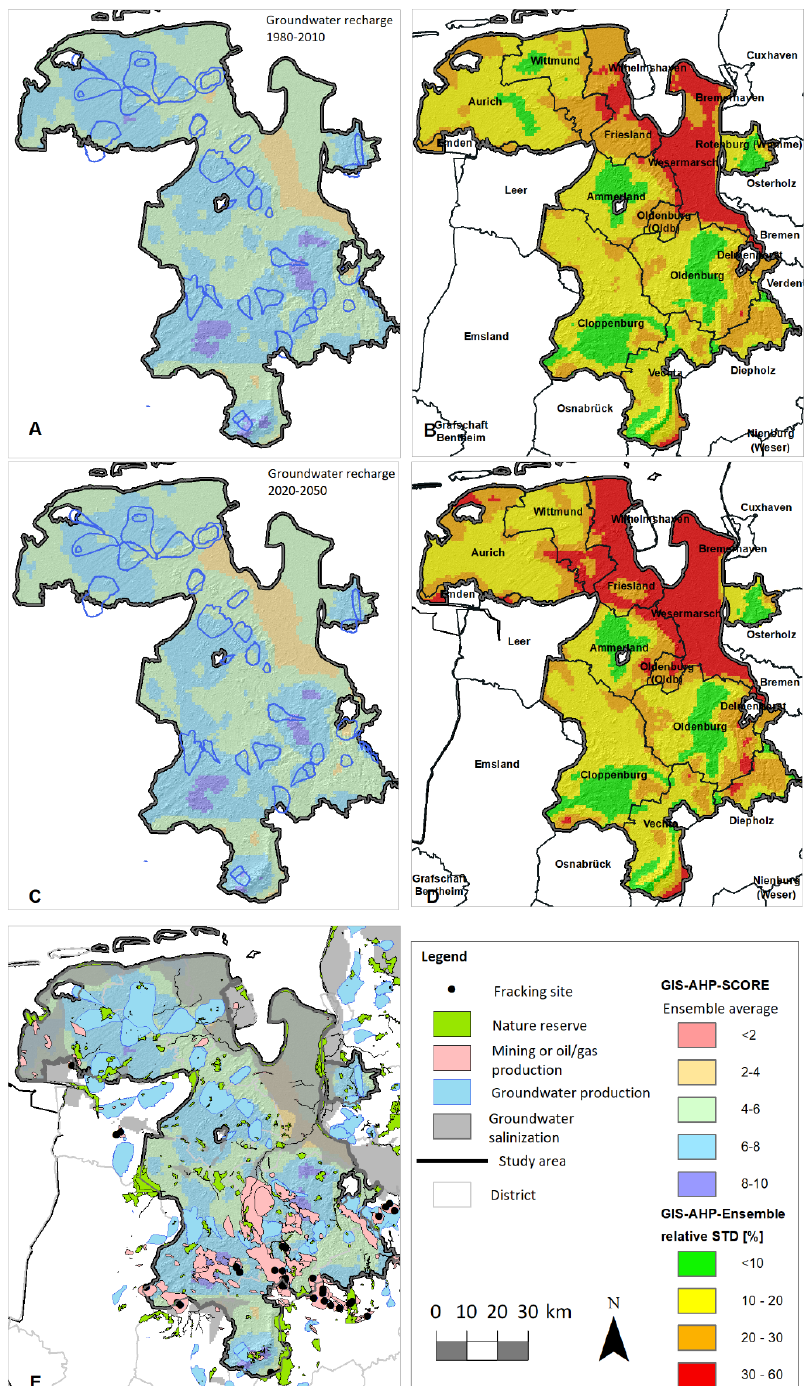
Figure 6. Results from the GIS-AHP ensemble: ( A ) average of GIS-AHP ratings from all five ensemble members together with long-established groundwater abstraction and protection areas, marked by deep blue lines (0 = insufficient site conditions, 10 = ideal site conditions), ( B ) standard deviation (STD) of the GIS-AHP scores across all five ensemble members, ( C ) average GIS-AHP scores across all five ensemble members under altered groundwater recharge condition for the period 2020 to 2050 (existing groundwater abstraction and protection areas are marked by deep blue lines), ( D ) relative standard deviation (STD) of GIS-AHP scores across all five ensemble members under altered groundwater recharge conditions for the period 2020 to 2050, and ( E ) GIS-AHP-scores from Figure 6A with other relevant environmental data.